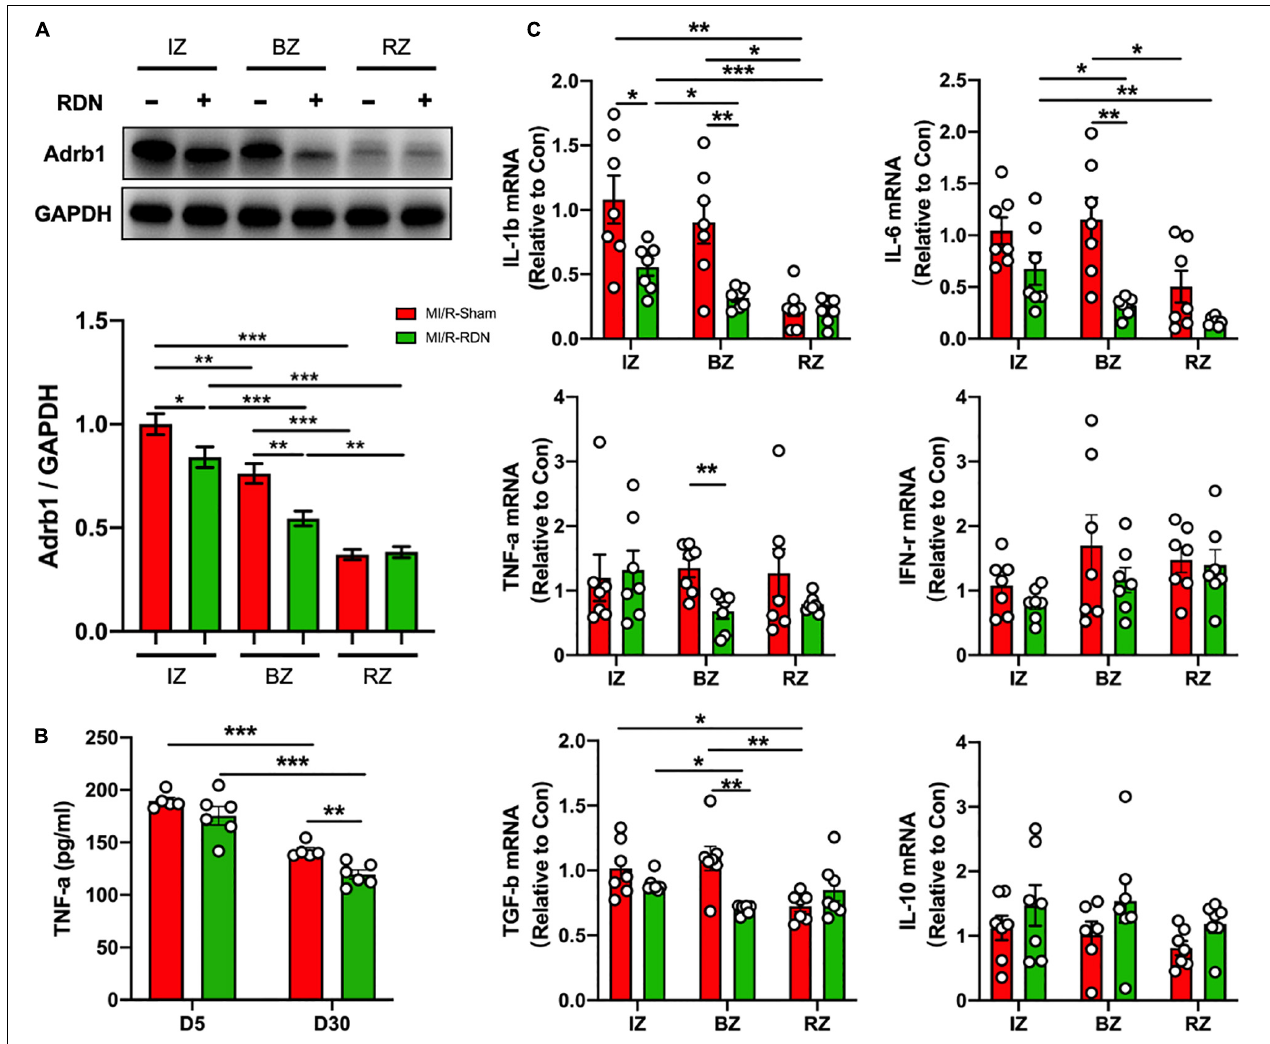
FIGURE 6 | Sympathetic activity and inflammation level in the LV IZ/BZ/RZ in MI/R following with sham or RDN treatment. (A) Western blots and statistics of the expression of adrenergic receptor beta 1 (Adrb1) in the infarct zones (IZs), border zones (BZs), and remote zones (RZs) of heart tissues ( n = 7 each group). (B) TNF- α levels in the circulation at 5 and 30 days post-RDN therapy were measured using ELISA ( n = 5 in the IM/R-Sham group, n = 6 in the IM/R-RDN group). (C) mRNA levels of inflammatory mediators in heart tissues. The expression of these genes was normalized to GAPDH expression and is shown as the fold change relative to the IZ in the MI/R-Sham group ( n = 6–7 each group). Data are shown as the means ± SEM. p -Values were shown and assessed by two-way ANOVA with Bonferroni test (A–C) . * p < 0.05, ** p < 0.01, and *** p < 0.001 (compared with the MI/R-Sham